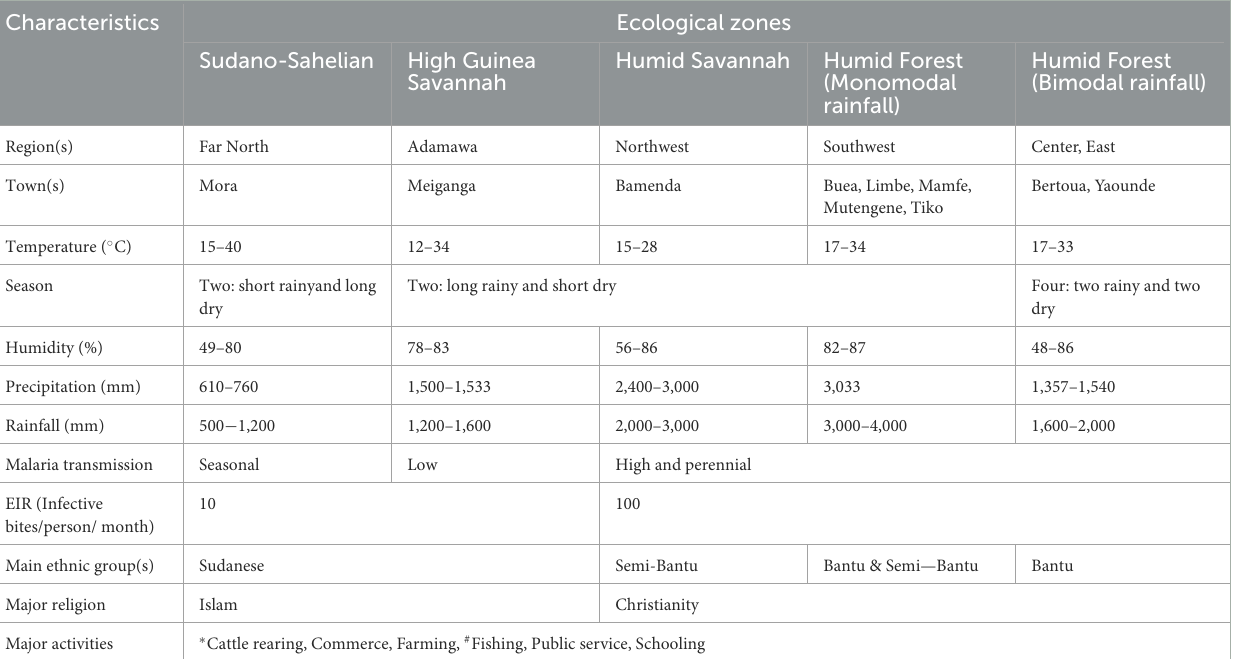
TABLE 1 Features of the study sites across the five ecological